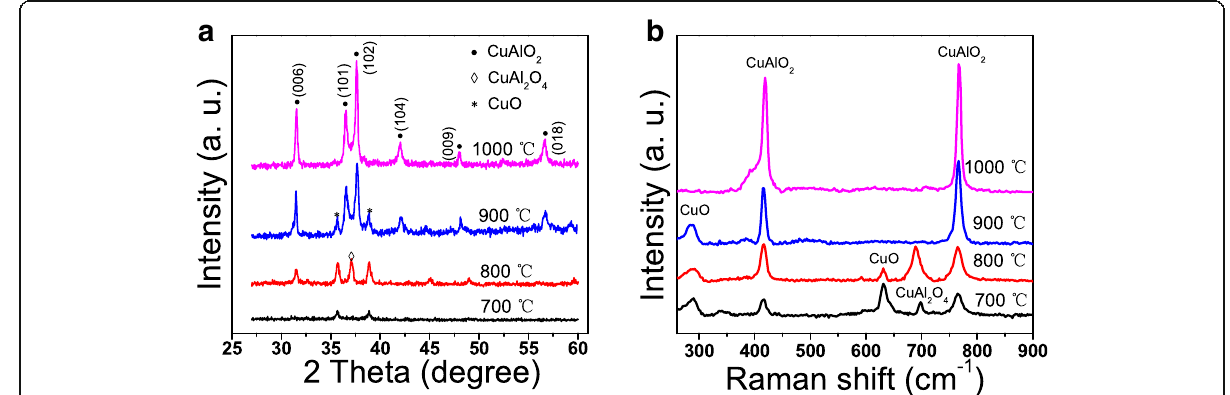
Fig. 1 a XRD patterns. b Raman spectra of the CuAlO 2 thin films annealed at different temperature